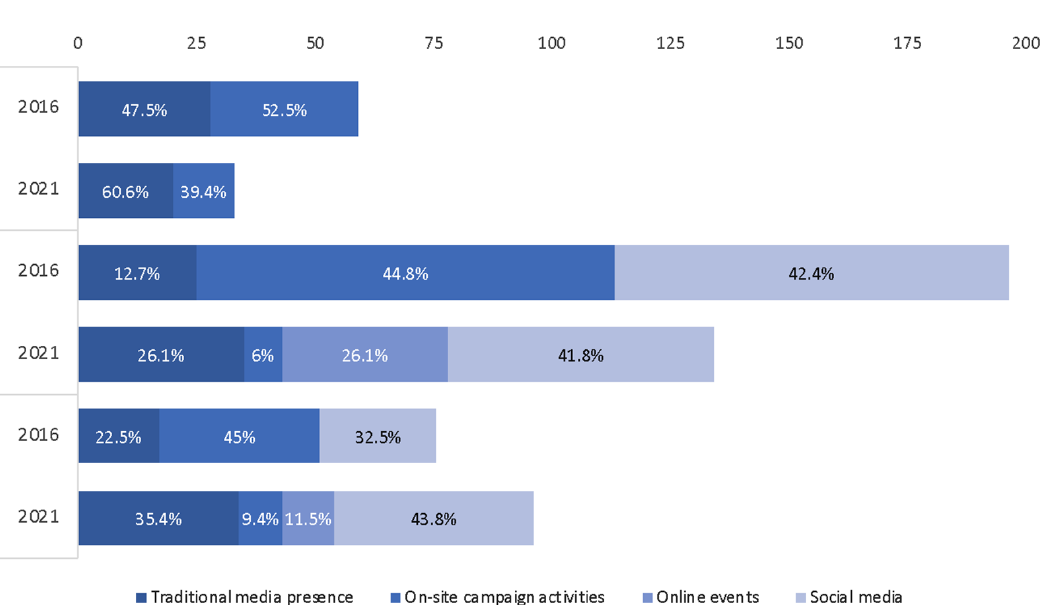
Figure 1. Traditional vs. Digital Campaigning. Comparison between the 2016 and 2021 presidential election campaigns. Source: Own data (see Section 3.1.1).